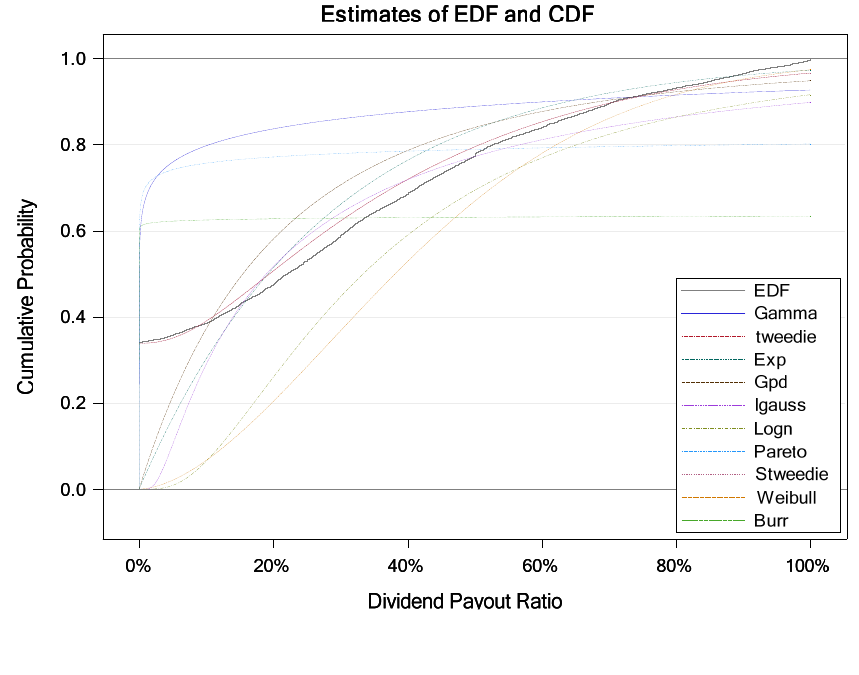
Figure 2 : Estimates of Empirical Distribution Function of Dividend Payout Ratio (EDF) and other distributions